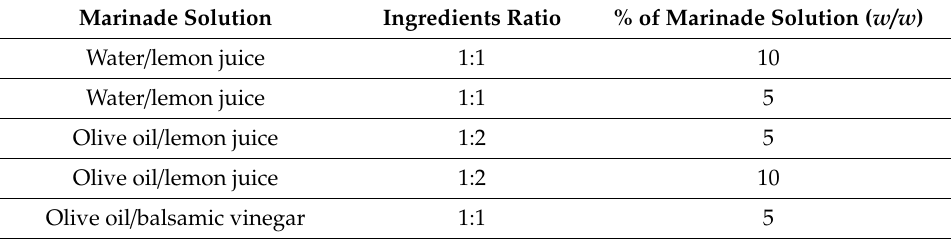
Table 1. Marinade solutions tested in the preliminary